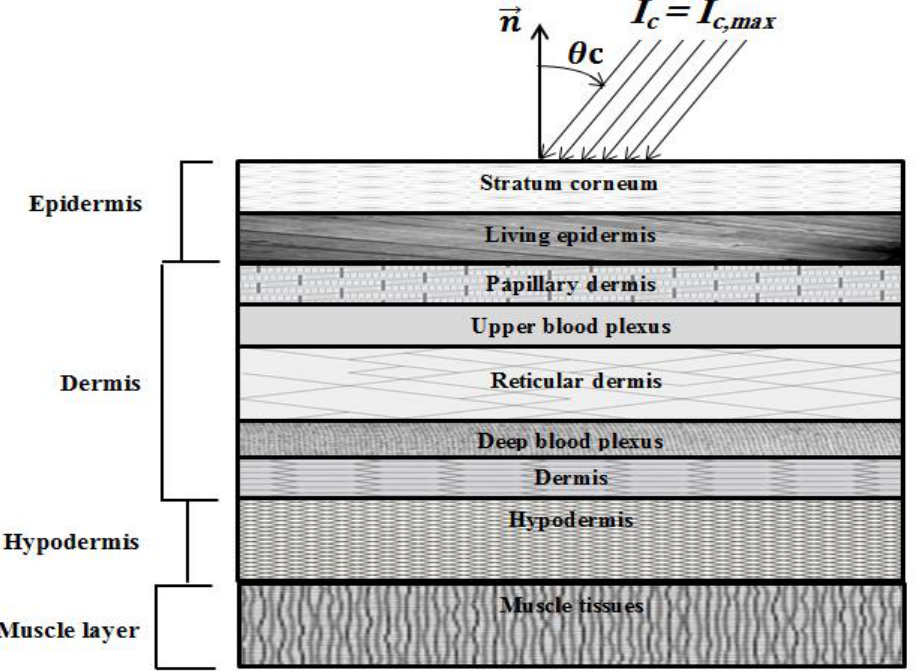
Figure 1. Schematic of the human skin subjected to ultrafast laser.